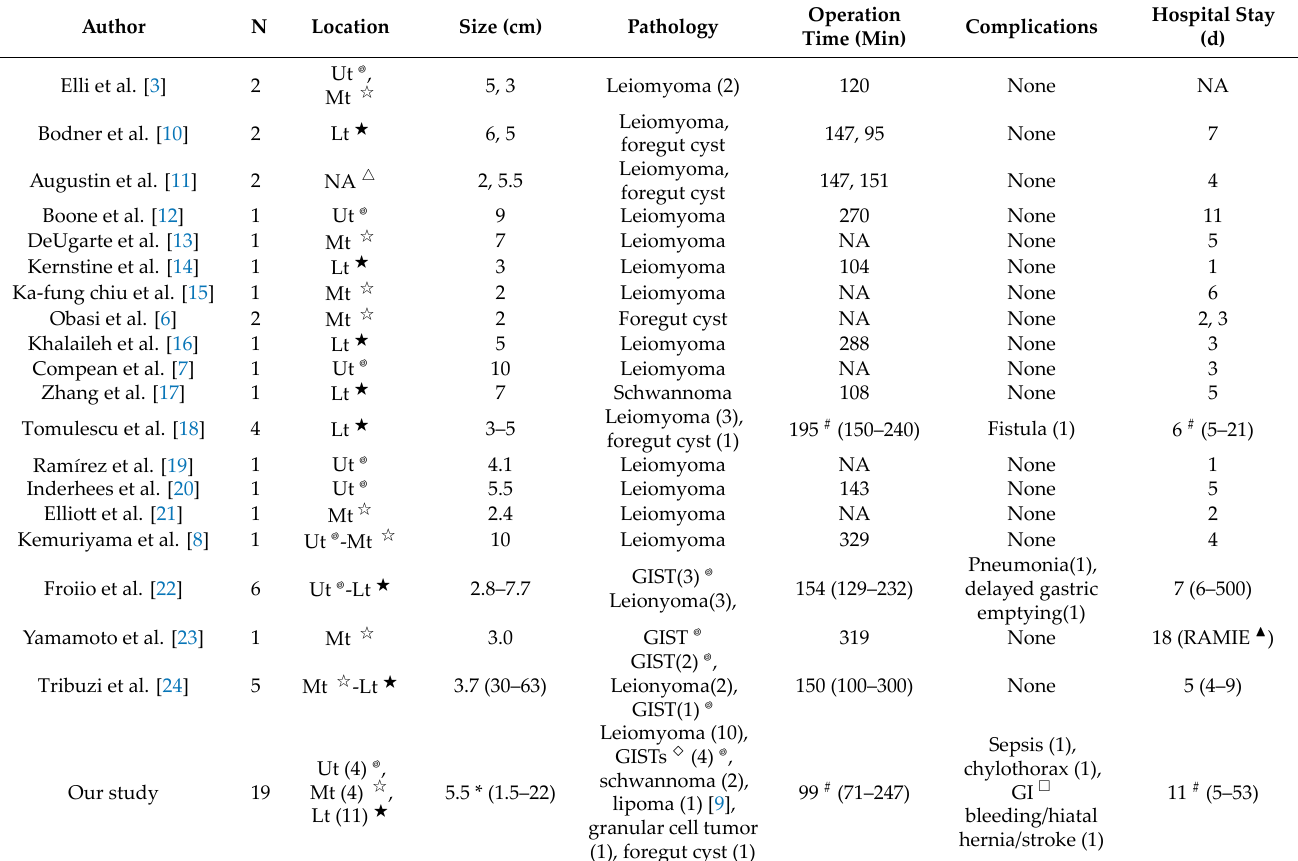
Table 1. Literature review of robotic‑assisted thoracoscopic